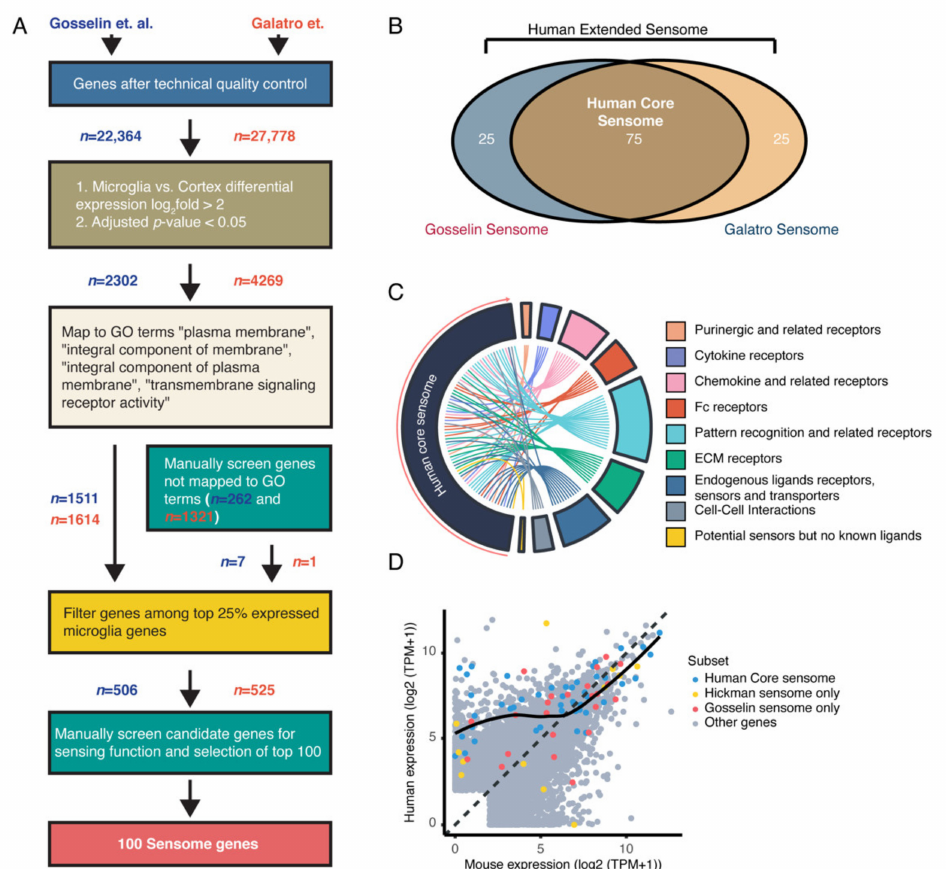
Figure 2. Identification of microglial human sensome. ( A ) Flow chart showing the selection of candidate genes using the Gosselin et al. human and Galatro et al. human microglial RNAseq datasets. A similar approach as in the mouse sensome selection was applied to finally select genes with translated proteins located in the cell membrane and that have a receptor function that are highly and specifically expressed by microglia. ( B ) Overlap between the Gosselin and Galatro mouse sensomes displayed in a Venn diagram, showing majority of genes from dataset overlap as candidate sensome genes. The total set is termed the “human sensome extended” and the shared set is called the “human core sensome” (Supplementary Table S3). ( C ) Human overlapping genes and assigned subgroups shown using Circ plot. ( D ) Distribution of human sensome genes showing a more evenly distributed over preferentially human and mouse expressed